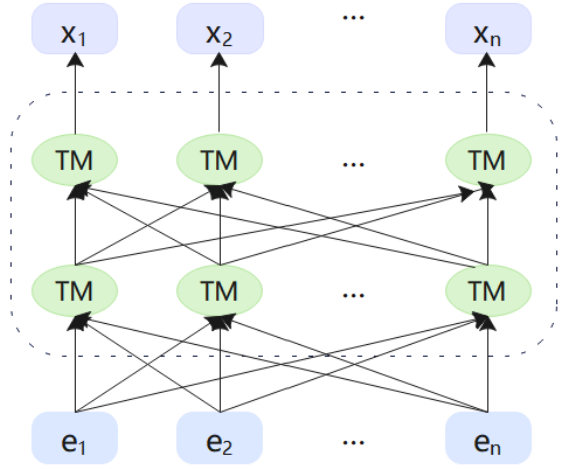
Figure 2. Bert structure.